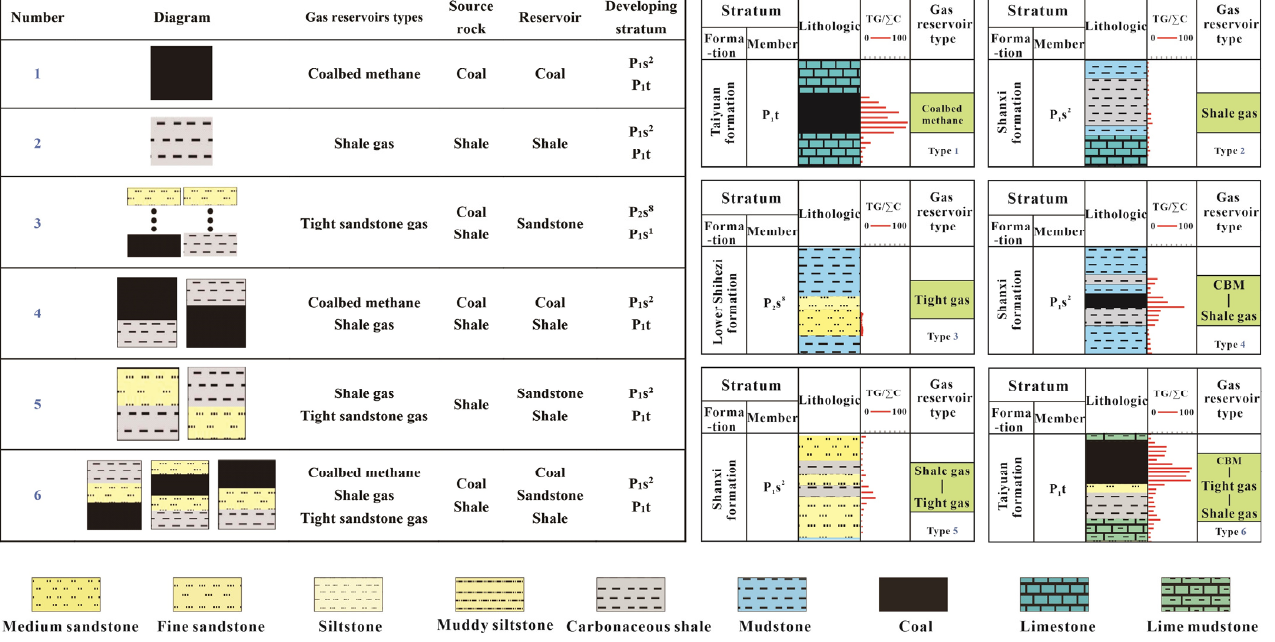
Figure 6. Types and distribution of coal measure gas reservoir assemblage in the Daning–Jixian Block.